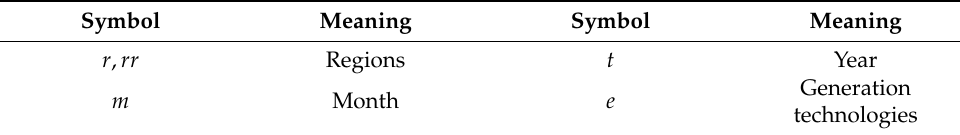
Table A1. Nomenclature: